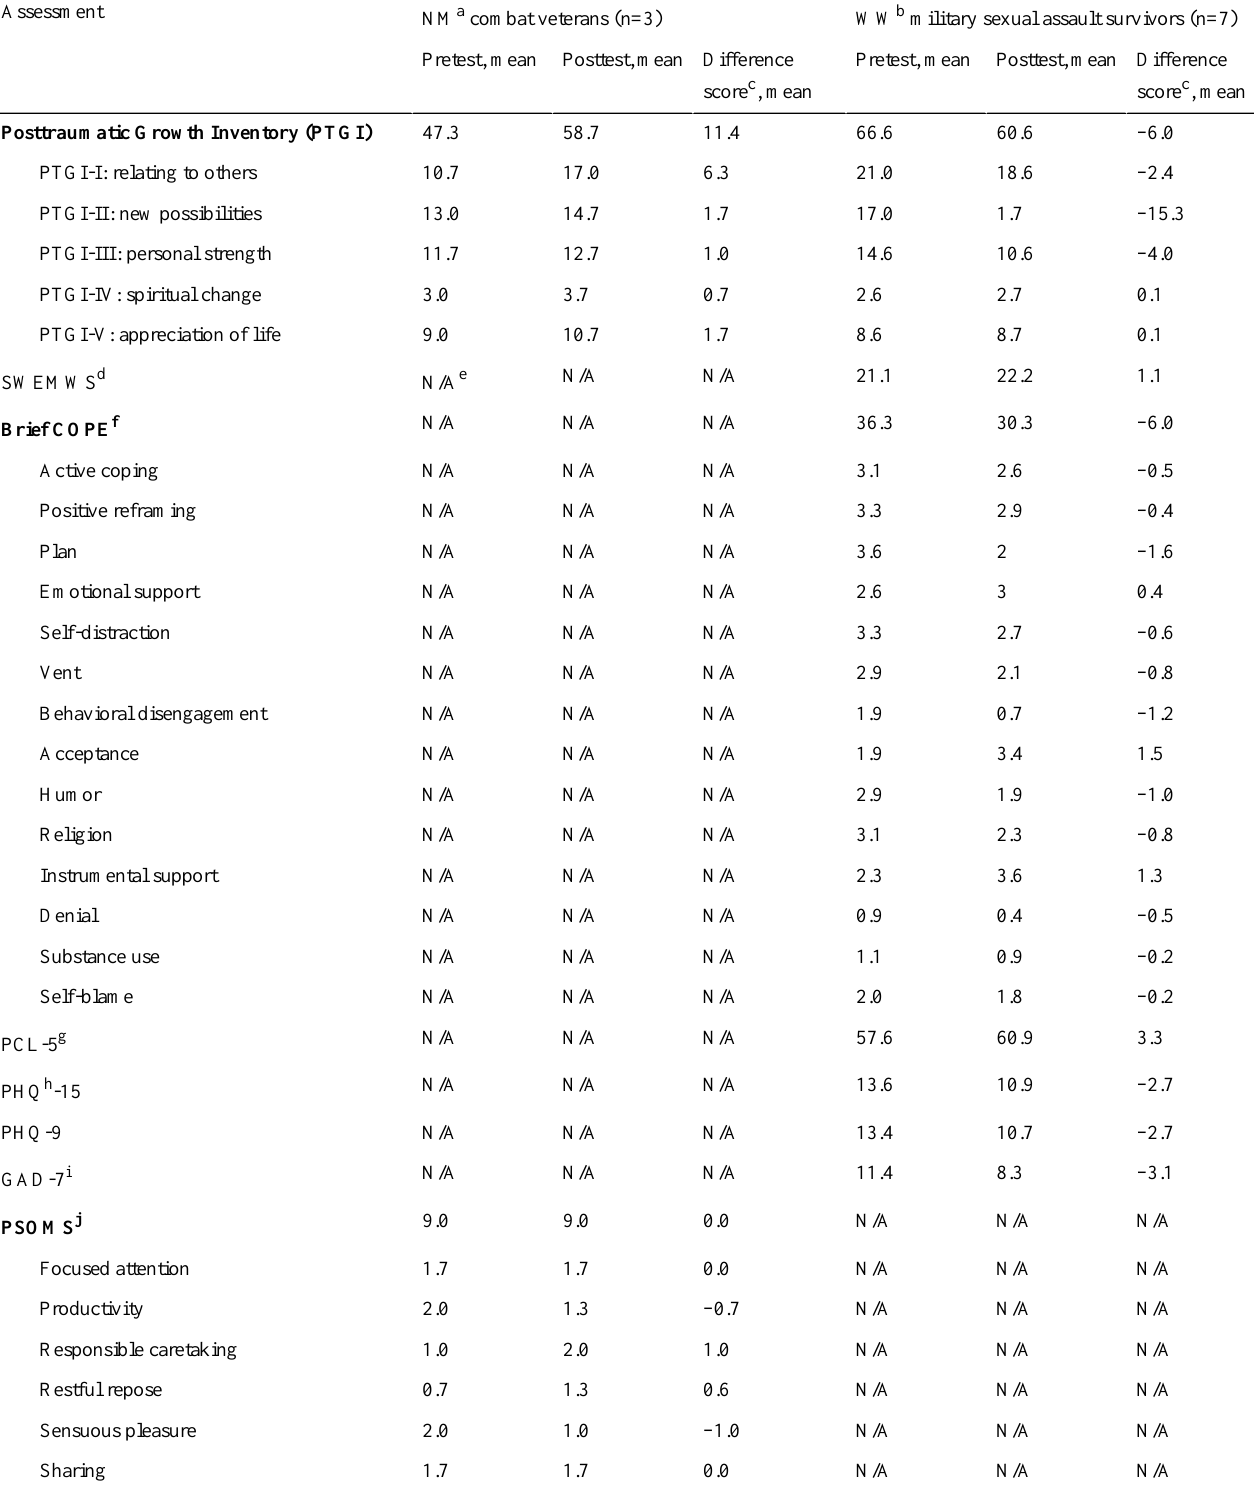
Table 3. Averages and change scores for treatment groups of Next Mission combat veterans and Women Warriors military sexual assault